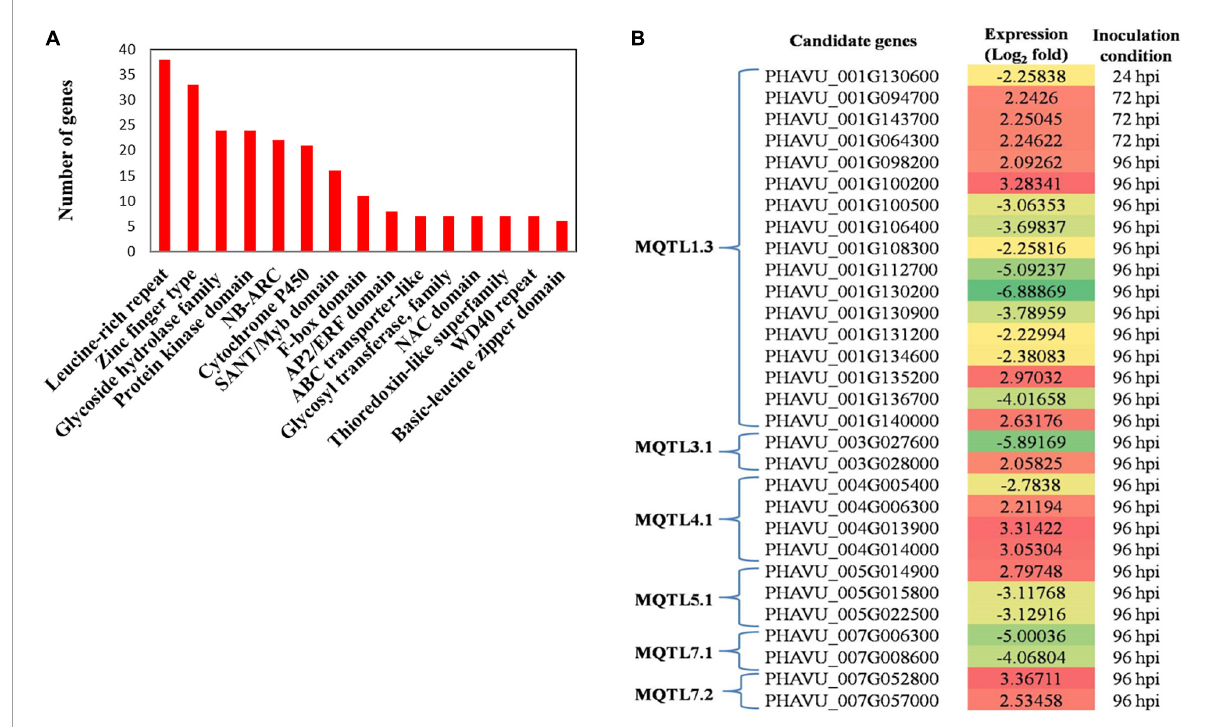
FIGURE3 (A) The distribution of number of candidate genes encoding different proteins associated with disease resistance traits. (B) Heat map showing differential expression of proteins encoded by candidate genes associated with MQTLs at different hours post inoculation (hpi) (FC = 3 to